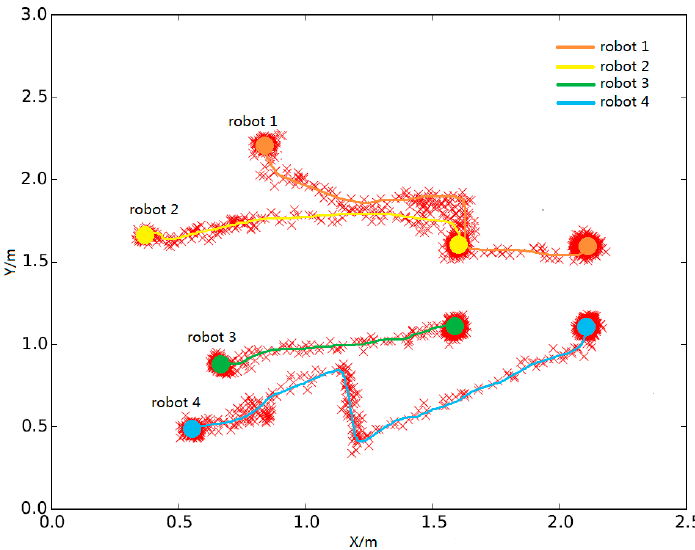
Figure 10. Experiment 1 data of UWB positioning system.